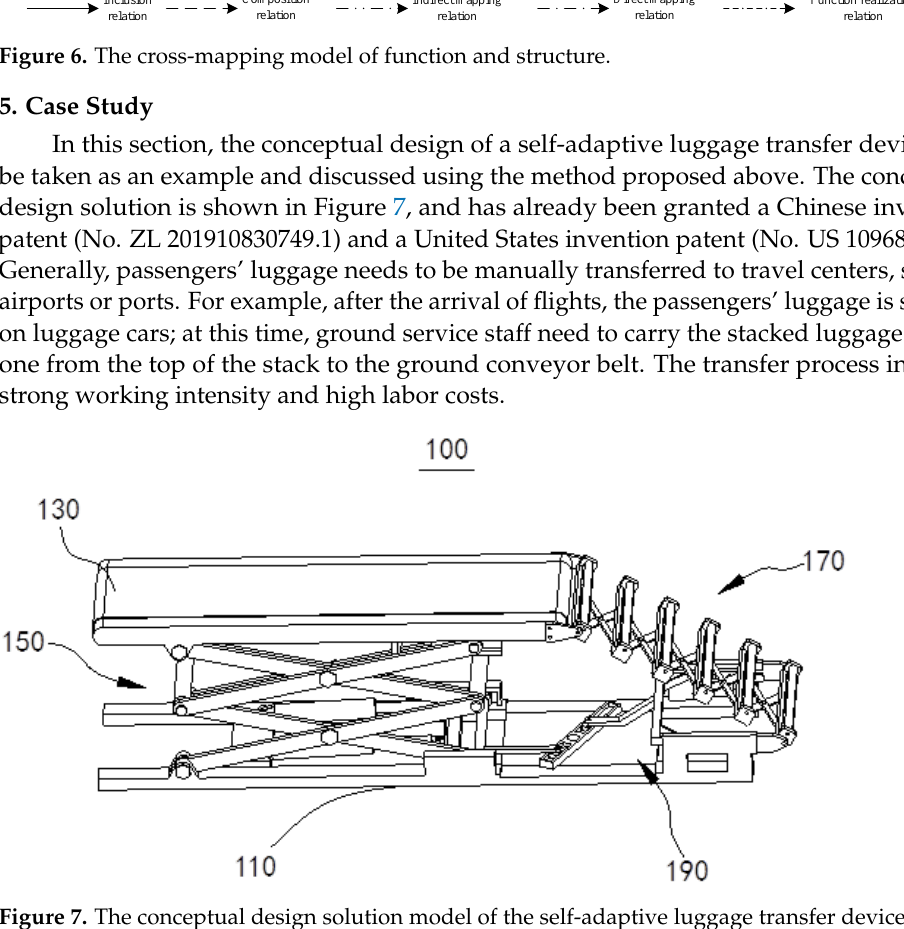
Figure 7. The conceptual design solution model of the self-adaptive luggage transfer device.